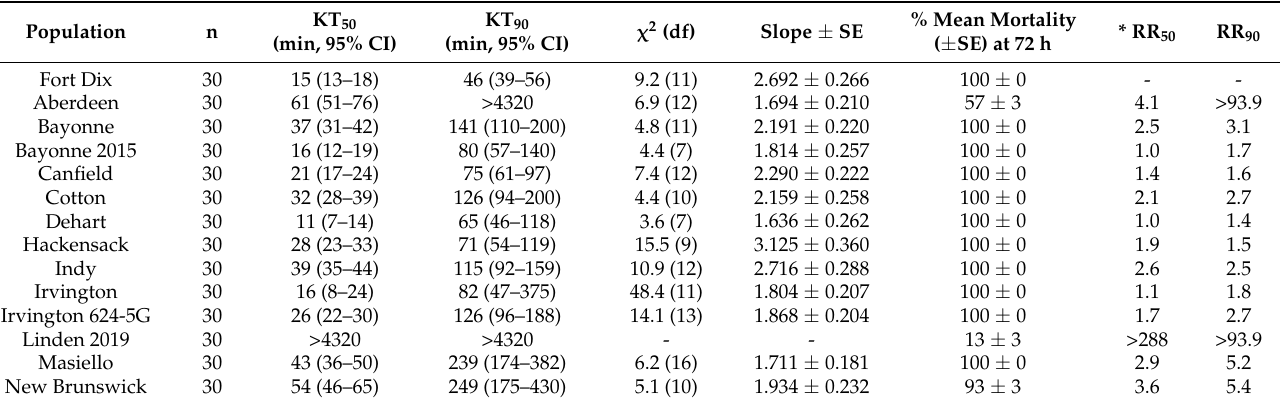
Table 2. Susceptibility (based on knockdown time, KT 50 and KT 90 ) of 13 field-collected C. lectularius populations to topically applied acetamiprid at a discriminating dose of 186 ng per adult.